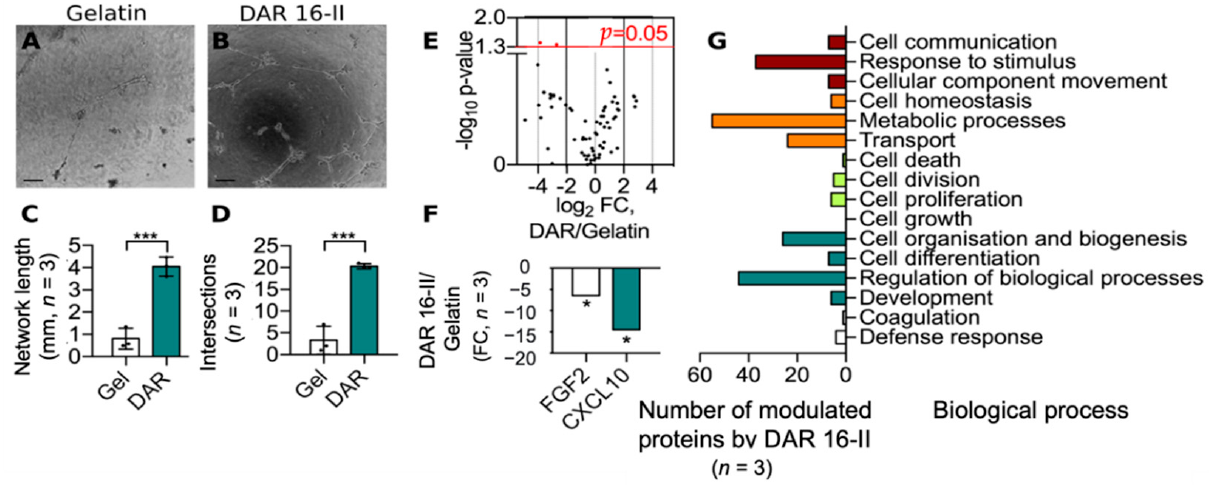
Figure 2. ( A , B ) Representative images (10× OM, scale-bars = 100 mm) of tubule-like structures formed by HUVEC cultured on Matrigel or DAR-16-II-enriched Matrigel; ( C , D ) the quantification of tubule-like structures’ lengths and interconnectivity; ( E ) a volcano plot representation of the datasets obtained from a low-density qRT-PCR-based array. Red dots represent differentially expressed genes; ( F ) a fold change representation of two down-regulated genes ( p < 0.05. FGF2, CXCL10) from the qRT-PCR-based array dataset; ( G ) GO analysis showing the number of differentially regulated protein amounts identified and quantified by mass-spectrometry-based proteome analysis and corresponding enriched processes. * p < 0.05, *** p < 0.001